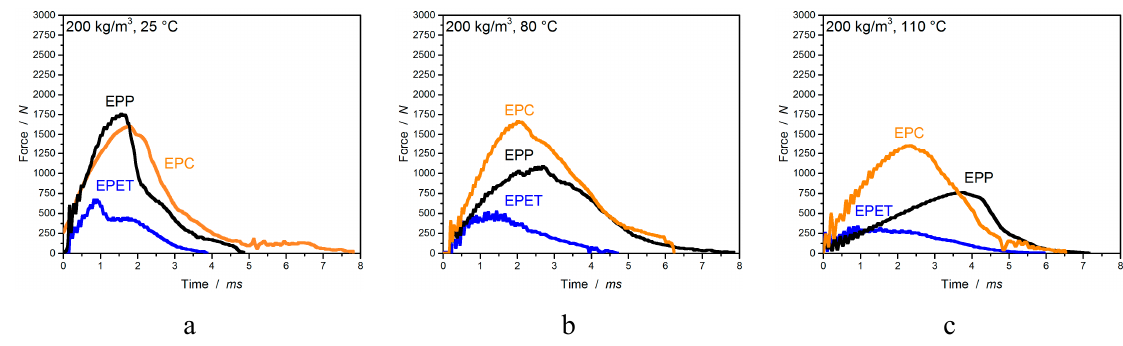
a b c Figure 12. Impact diagrams for EPP, EPC, and EPET at 25 ( a ), 80 ( b ), and 110 °C ( c ) with a velocity of 4.4 m/s.